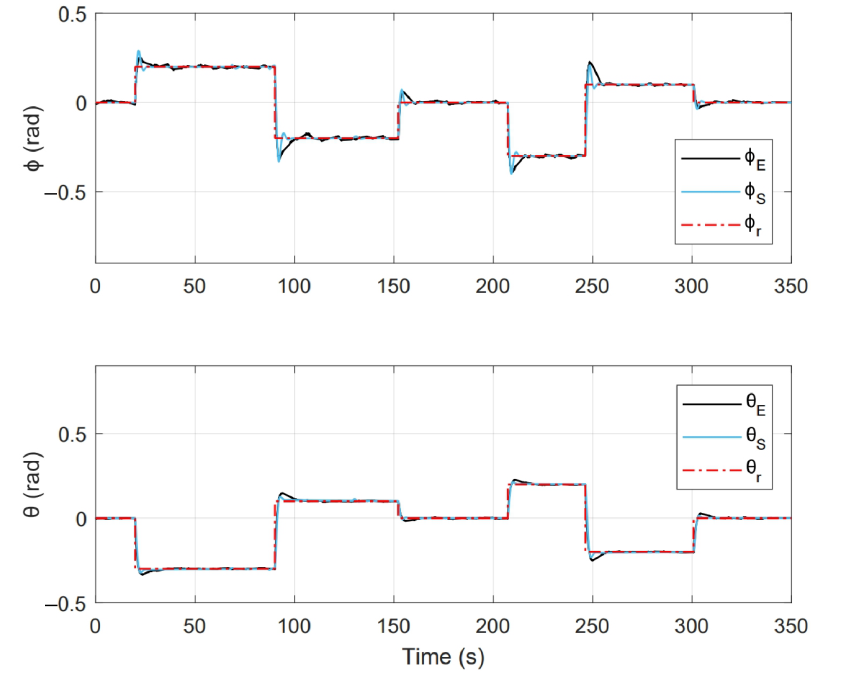
Figure 22. System response obtained in PID control experiment.